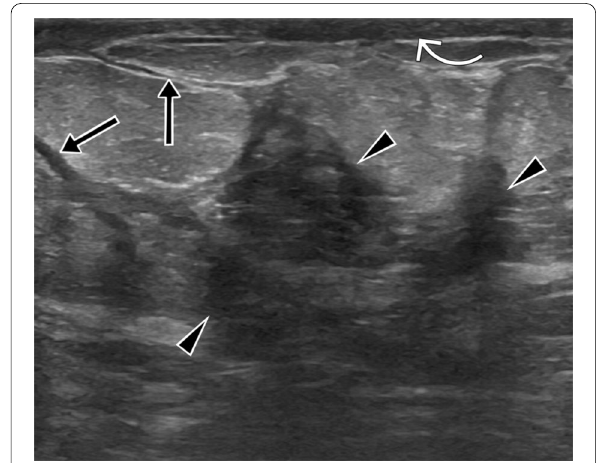
Fig. 5 Ultrasound image of a 34-year-old female patient (she had a recently developed clinically suspicious palpable lesion) diagnosed with breast tuberculosis demonstrate nodular tuberculosis (arrowheads). The mass is observed as a well-circumscribed, oval-shaped, heterogeneous solid lesion. BIRADS 4